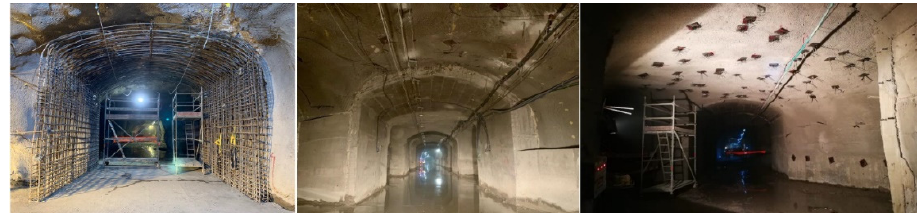
Figure 5. Production and extraction drift support constructions [47].